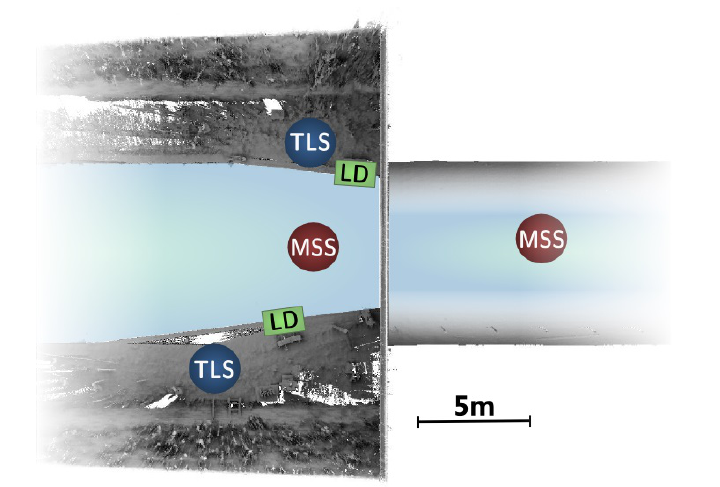
Figure 6. Illustration of the acquisition setup seen from above, featuring TLS and MSS scanning positions, as well as the location of ladders (LD).